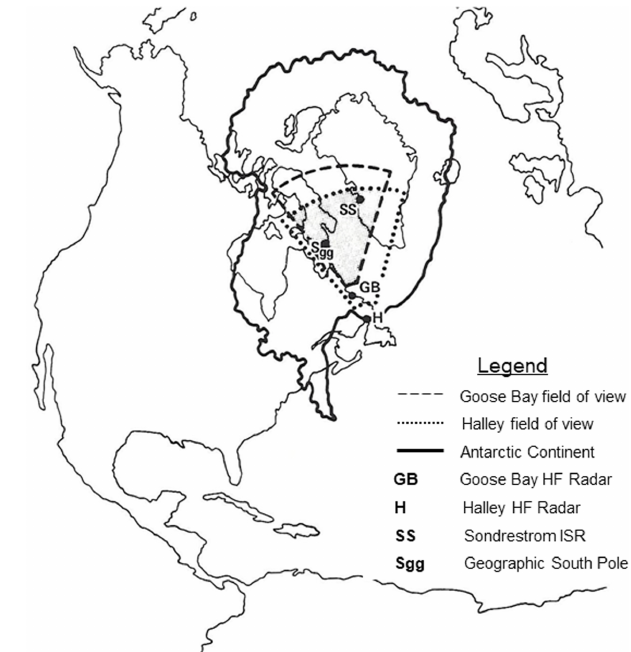
Figure 4. Map of the Northern Hemisphere upon which the mag- netically conjugate regions of Antarctica are superimposed. The Northern Hemisphere land masses are bounded by the thin black lines, while the Antarctic continent is bounded by the bold black line. The Halley (H) HF Radar is near the coast of Antarctica, while the Goose Bay (GB) HF Radar is near the northeastern coast of Canada. Also indicated on the map are the nearly overlapping con- jugate fields of view of the Goose Bay radar (bold dashed lines), the Halley radar (bold black dots). The location of the Sondrestrom Incoherent Scatter Radar (SS) and the mapped location of the Geo- graphic South Pole (S gg ) are also indicated. This figure was origi- nally produced by the British Antarctic Survey in support of a pro- posal to the Office of Polar Programs at the U.S. National Science Foundation. The proposal was entitled the Polar Anglo-American Conjugate Experiment (PACE).